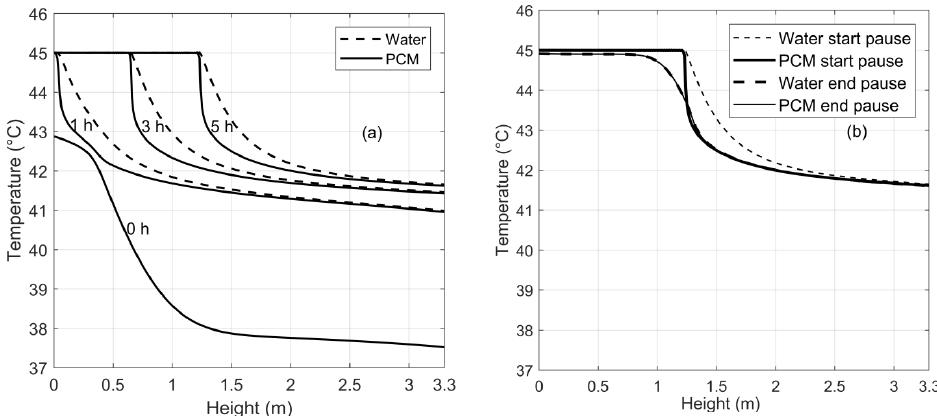
Figure 4. Evolution of the thermocline during ( a ) the first charge phase and ( b ) the first idle period.